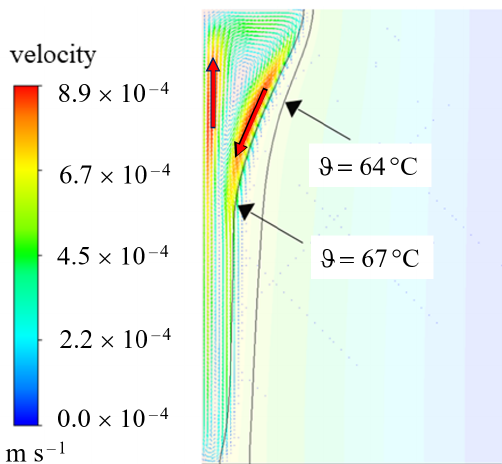
Figure 9. Velocity profile at 3600s for the AHC model with a bulged shape of phase front due to natural convection (compare also to Figure